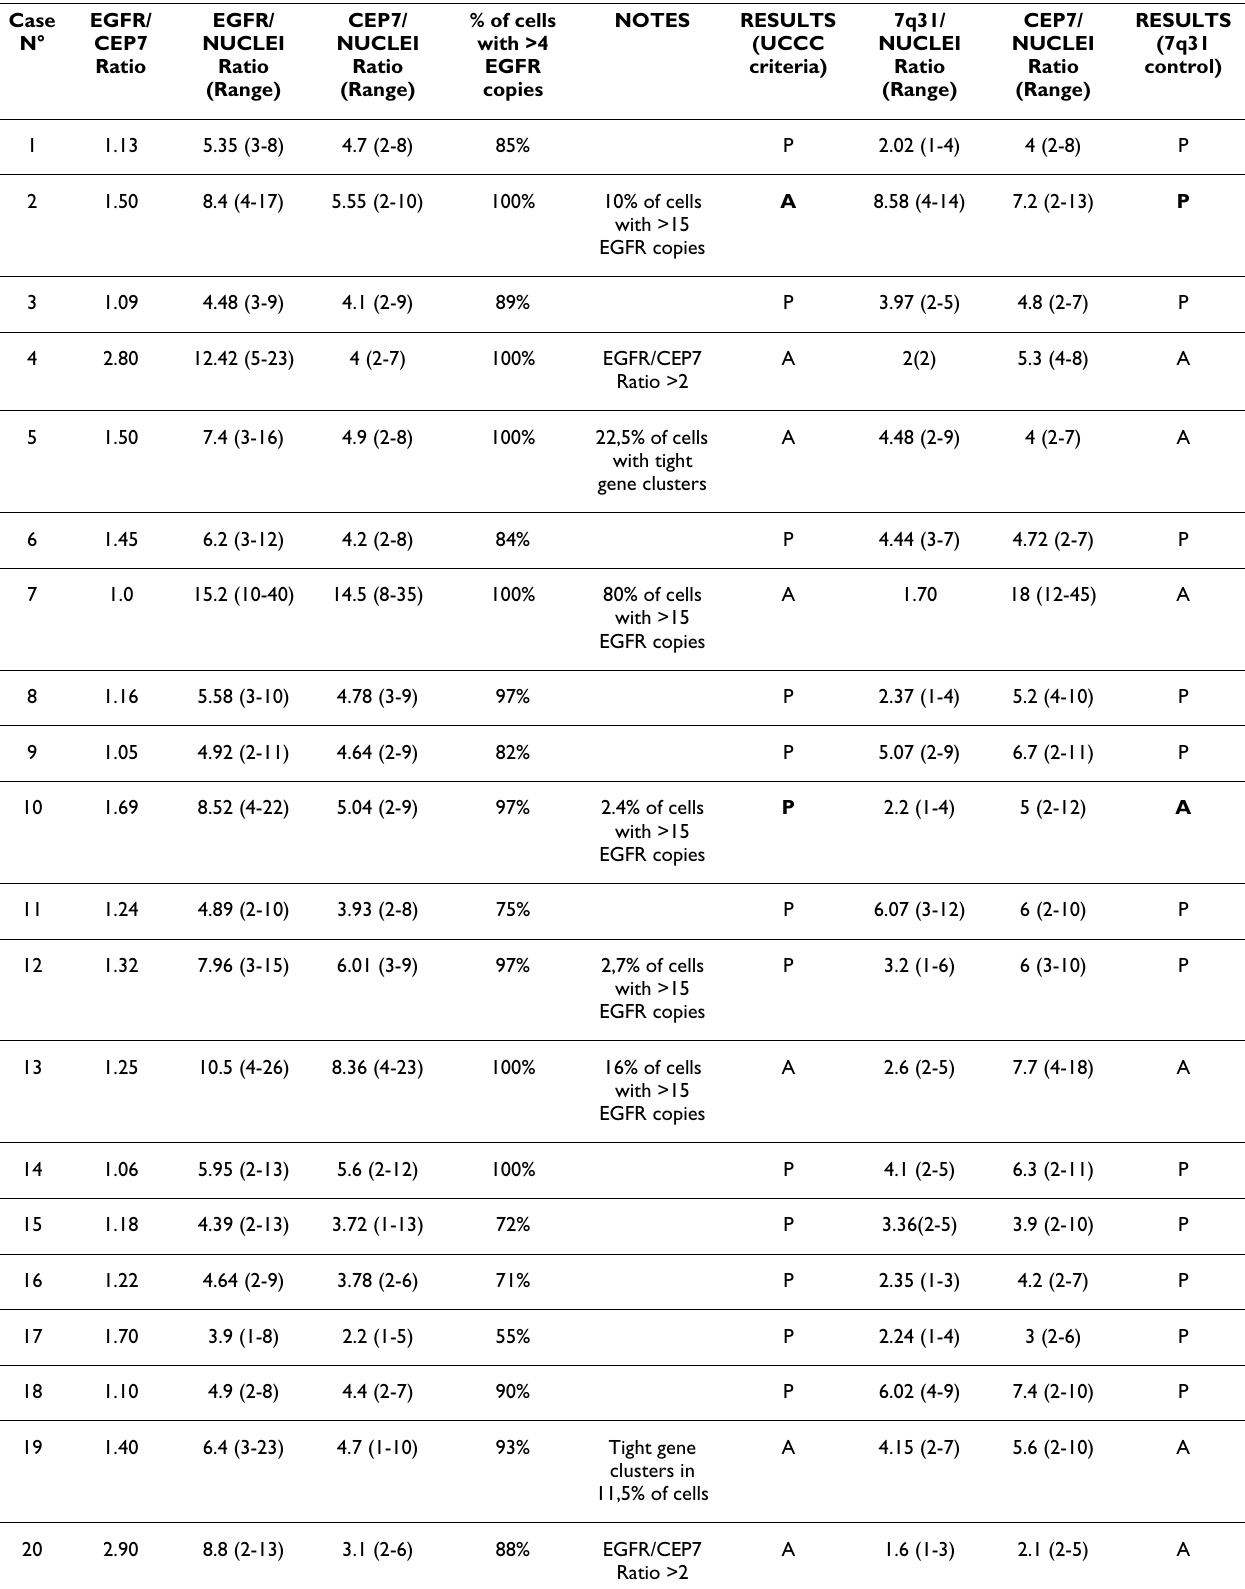
Table 1: FISH results according to UCCC criteria and 7q31 control Case